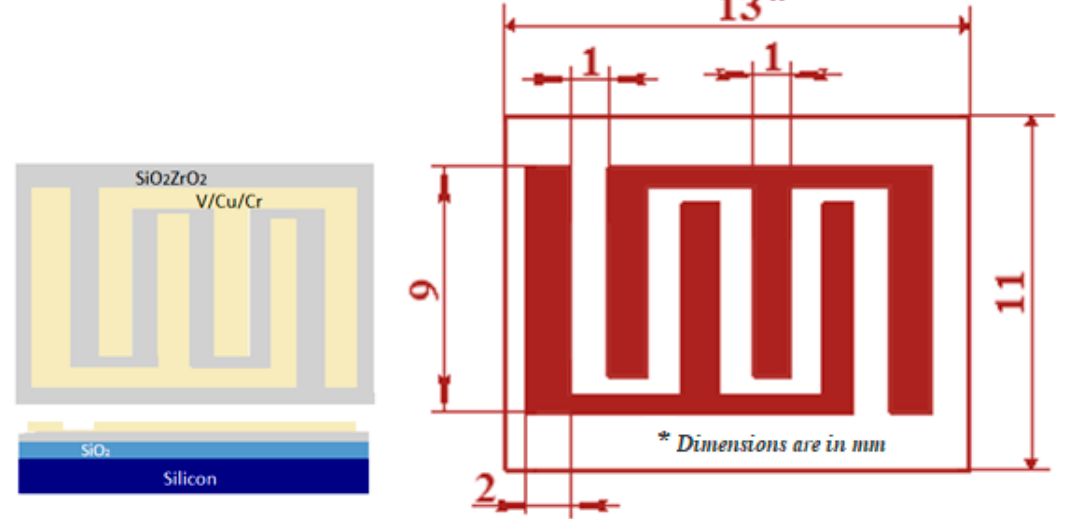
Figure 1. Schematic diagram of the fabricated SiO 2 ZrO 2 -based sensor.